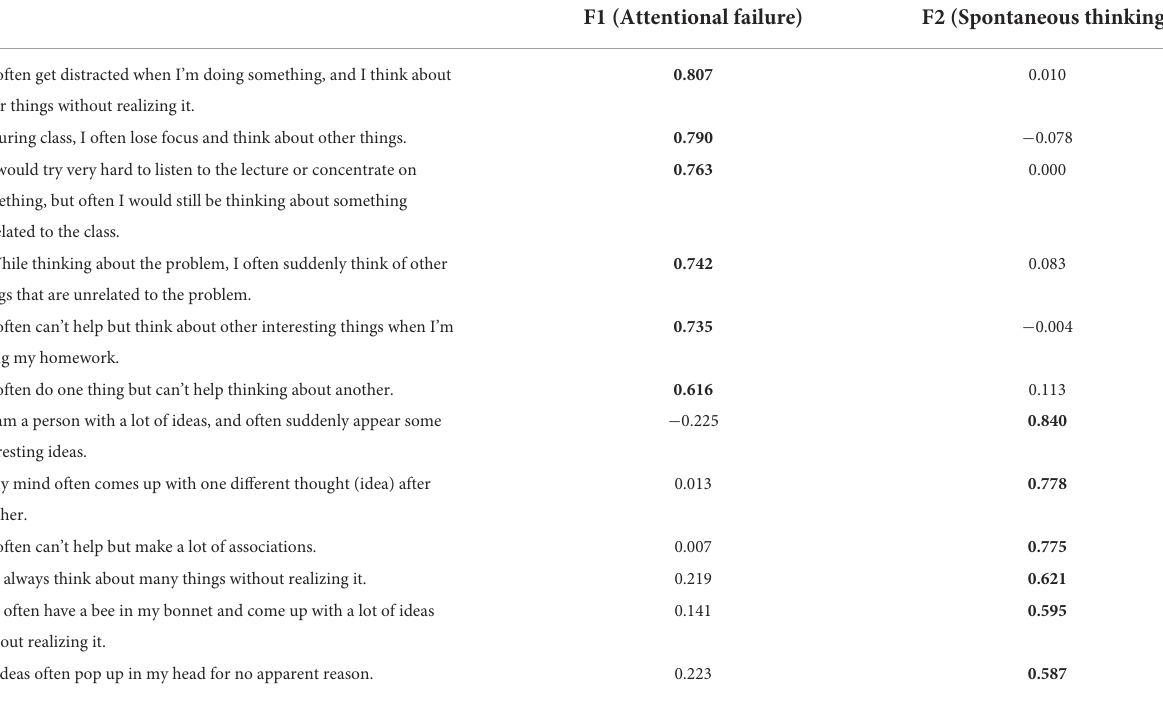
TABLE 1 Factor loadings of the CMWS-F.